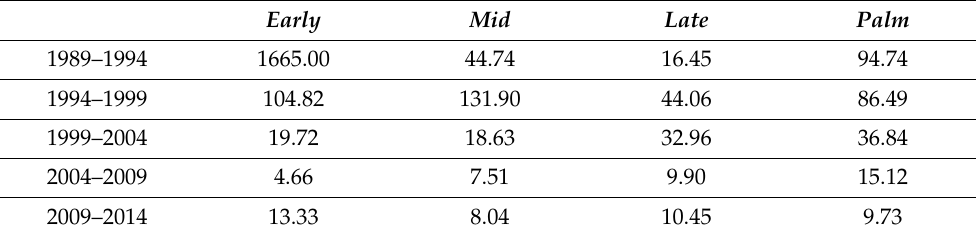
Table 1. Recruitment rate (%) for each PFT during any two consecutive censuses of the 85 continually censused plots at Bisley Experimental Watersheds, Luquillo, Puerto Rico.